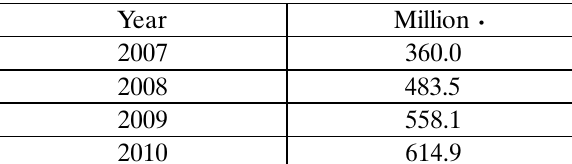
Fig 3. Market segments of